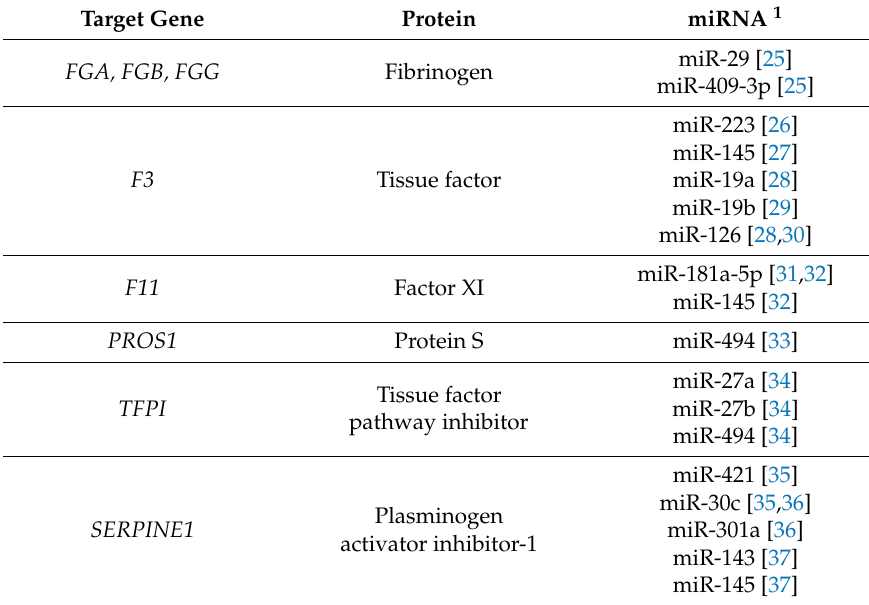
Table 1. MicroRNAs (miRNAs) reported to regulate hemostatic